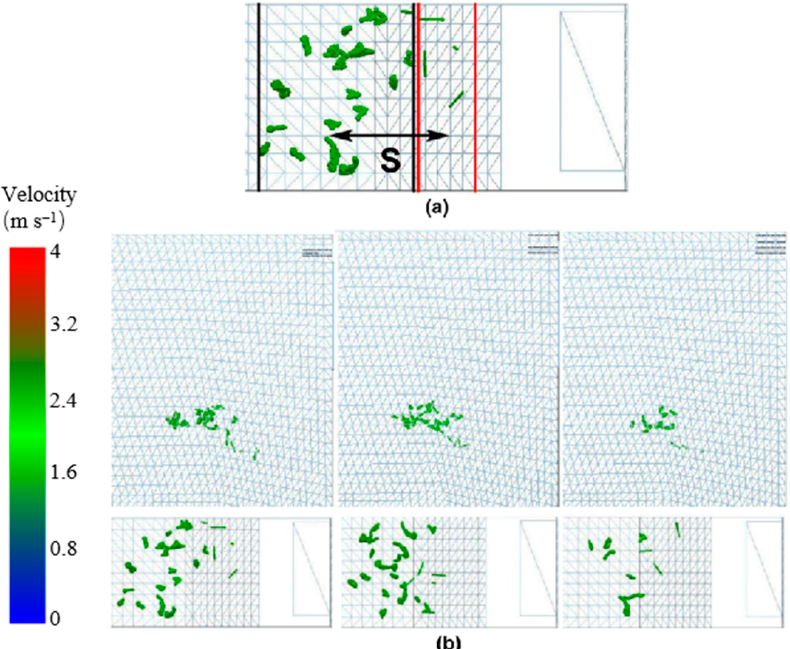
Figure 11. Discrete tea material distribution. ( a ) S is the distance from center of leaf distribution to center of stem distribution. ( b ) Distribution of particles in the flow field after the grid plate was removed. In Figure 11b, top three drawings represent the main views, and the bottom three drawings represent the corresponding top views.